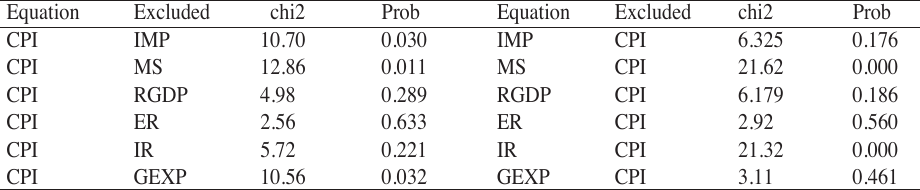
Table 3: Results of Granger Non-Causality